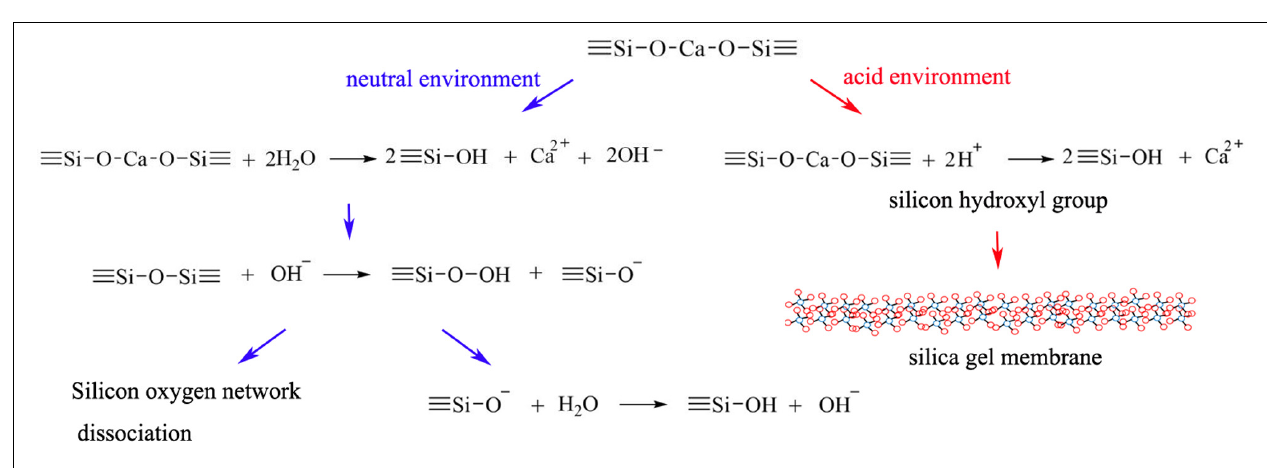
FIGURE 7 | (A) The Si, Ca, and P ion release from BG nanoparticles/alginate paste. (B) Change in pH of BG nanoparticles/alginate paste immersed PBS (pH 7.4) and butyric acid solution (pH 5.4). The data are presented as mean ± SD from 3 independent experiments ( n = 3). BA: Butyric Acid; BG: BG nanoparticles/alginate paste; D: Day.